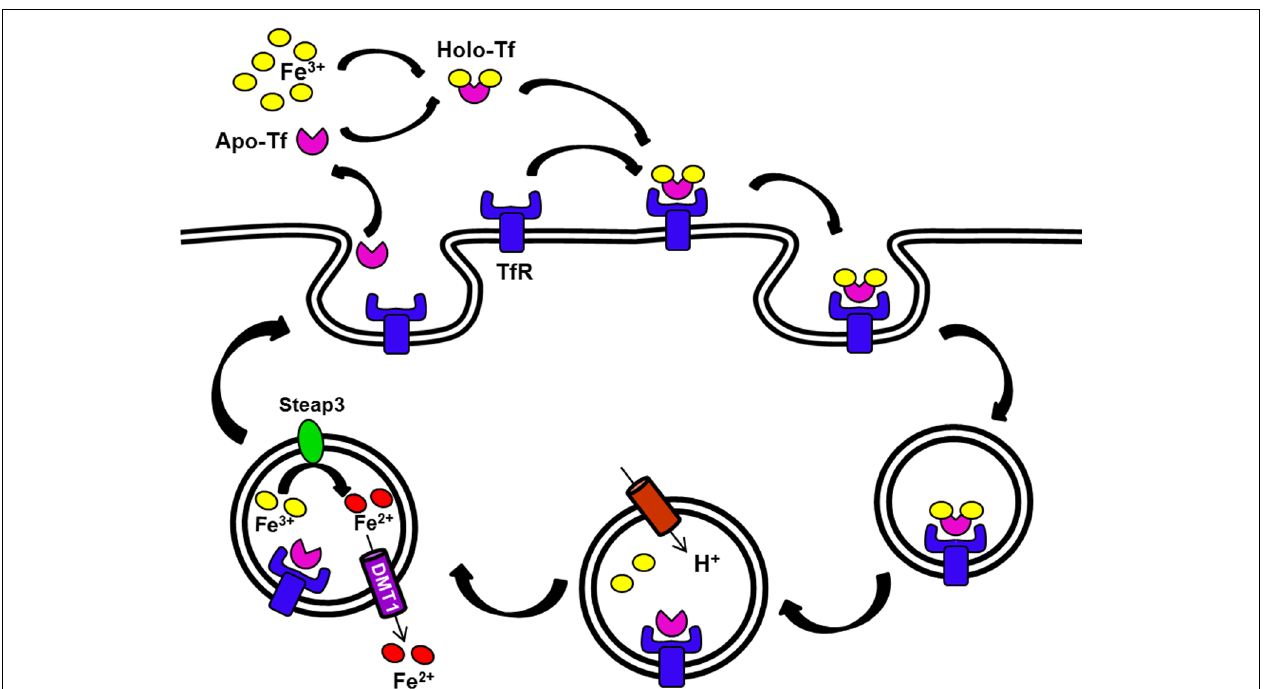
complex recycles back to the cell surface. Ferric iron is reduced in the endosome (Steap3), and then released into the cytosol by DMT1. The G185R mutation of the Belgrade rat produces DMT1 that is defective in this step, thus some iron remains bound to Tf and recycles back with the